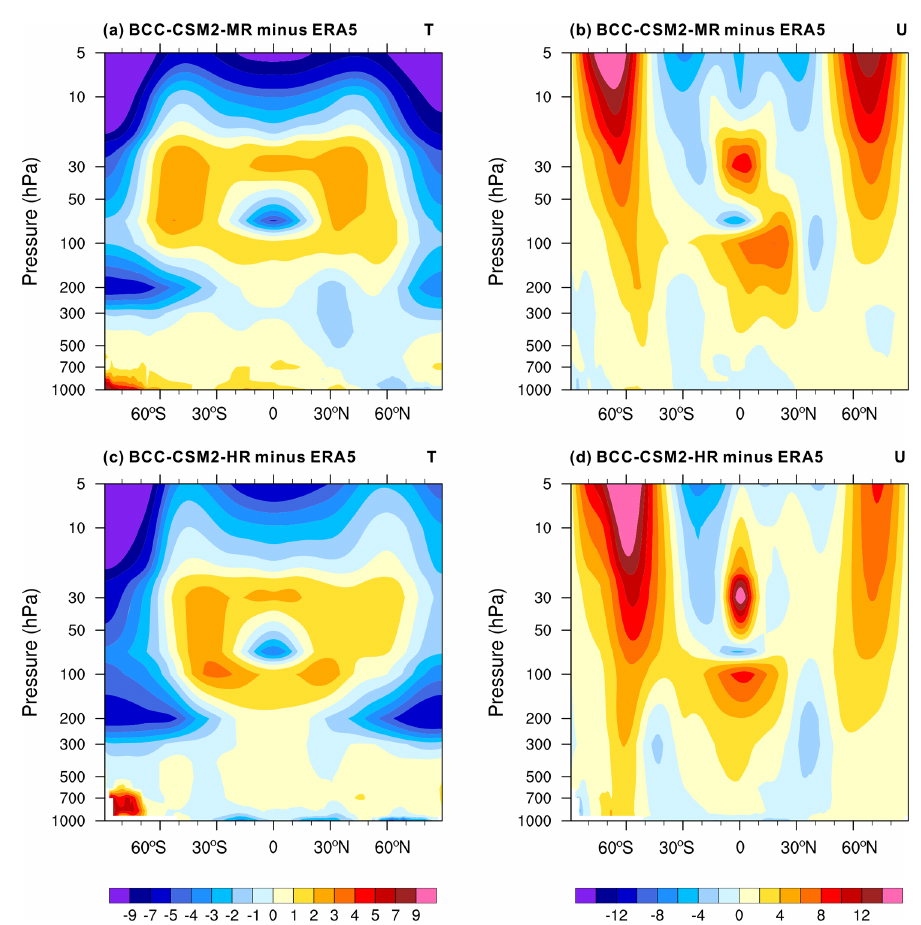
Figure 6. Zonally averaged annual mean temperature biases ( a , c , in K) and zonal wind biases ( b , d , in ms − 1 ) averaged for the period from 1995 to 2014 for (a, b) BCC-CSM2-MR and (c, d) BCC-CSM2-HR, with respect to the ERA5 reanalysis